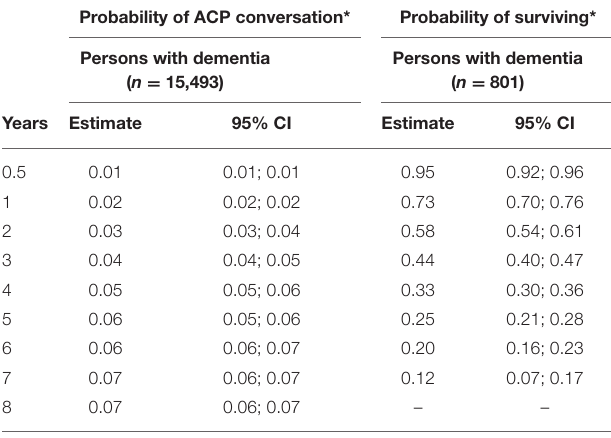
TABLE 3 | Probability of a first ACP conversation within 6 months up to 8 years after dementia diagnosis and probability to survive at least 6 months up to 7 years after